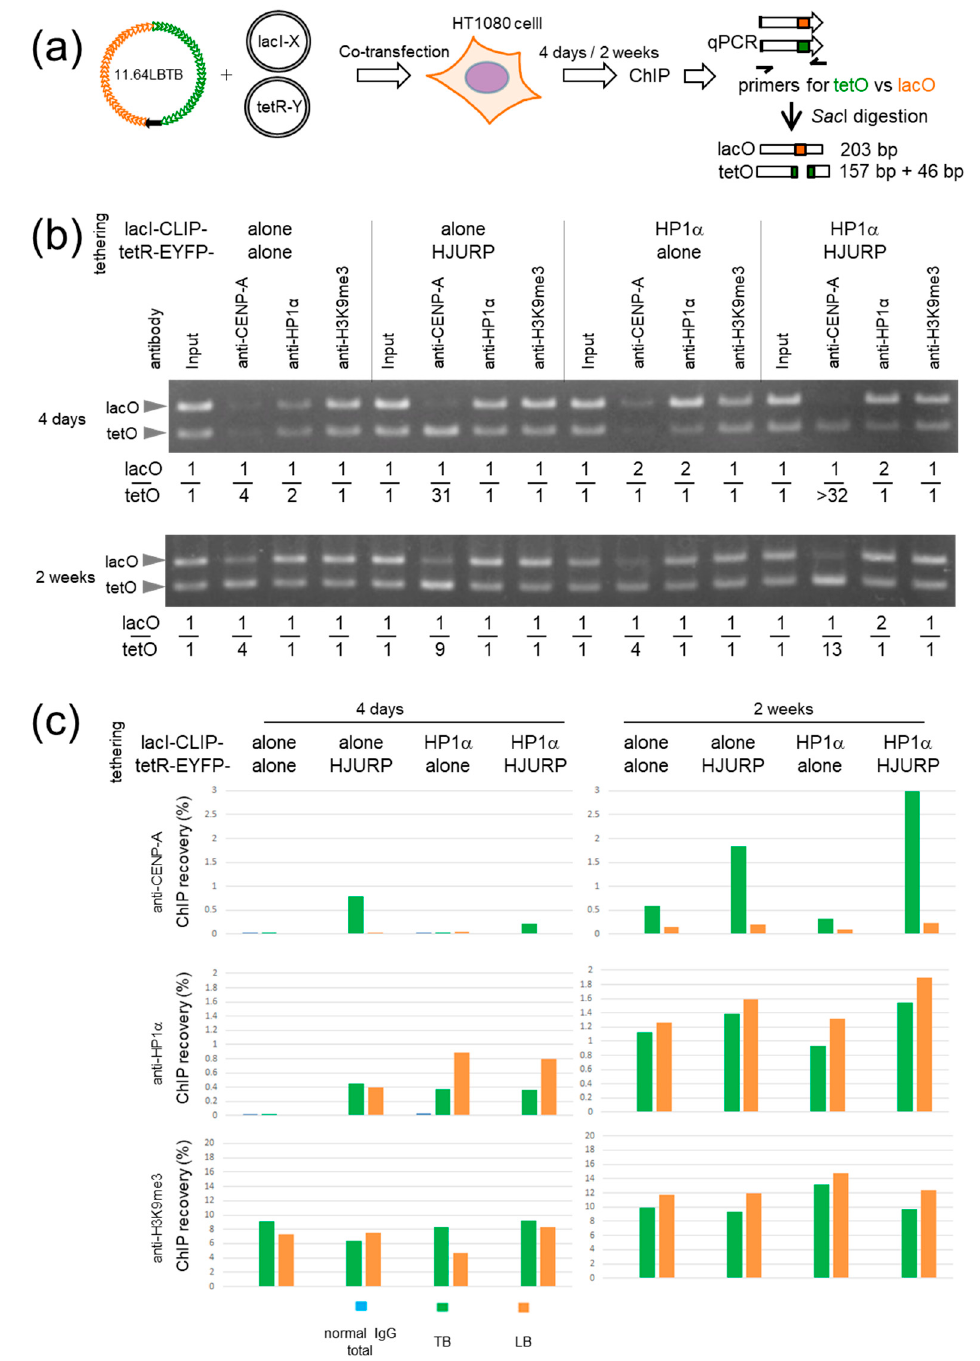
Figure 3. Tethering effect on chromatin formation in HAC precursors. ( a ) Cartoon of the experiment. ( b ) Results of competitive PCR after 4 days (upper) and 2 weeks (lower) of transfection. ( c ) Results of qPCR. Recovery of TB and LB was calculated from the lacO/tetO ratio obtained by the competitive PCR in ( b ) using the following formula; LB = (recovery × 2)/(ratio + 1), TB = (recovery × ratio × 2)/(ratio + 1).